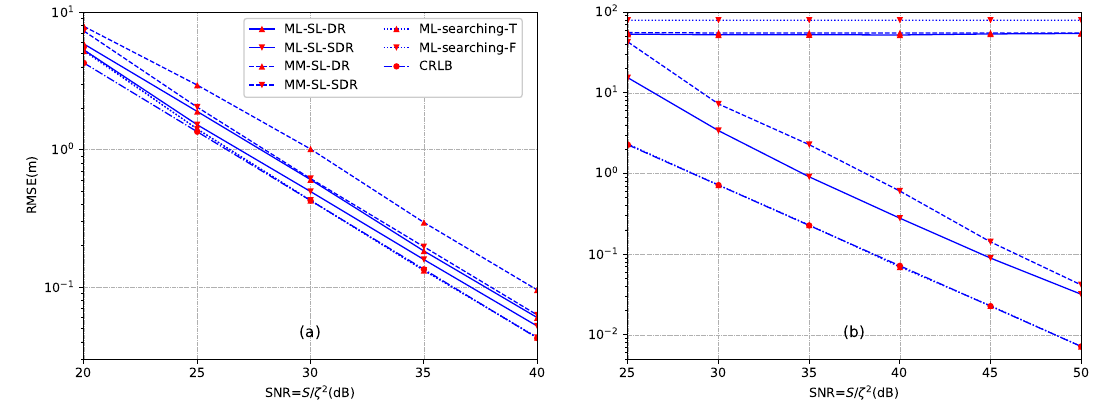
Figure 5. Comparison of searching method of ML and the proposed methods. ( a ) the source is located at y = [ 10,10 ] T ; ( b ) the source is located at y = [ 10,80 ] T .